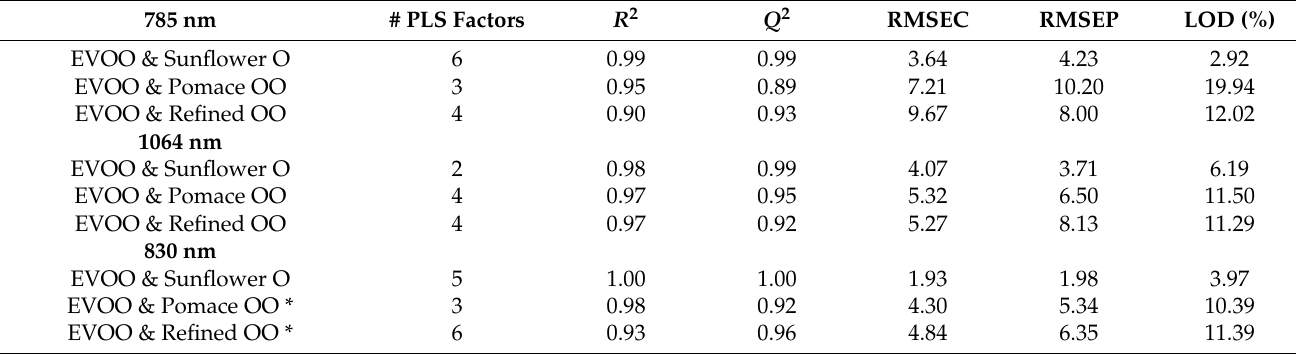
Table 1. PLSR results for the bootstrap models of the adulterated oils in EVOO with data collected in vial